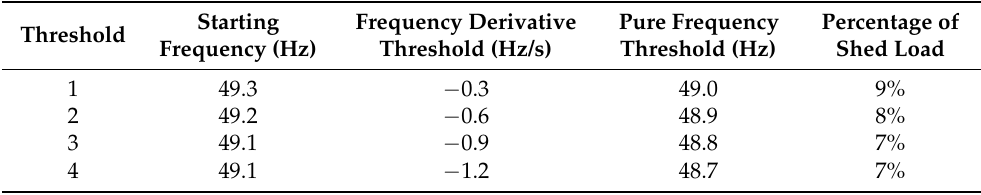
Table 2. Load shedding settings [38].